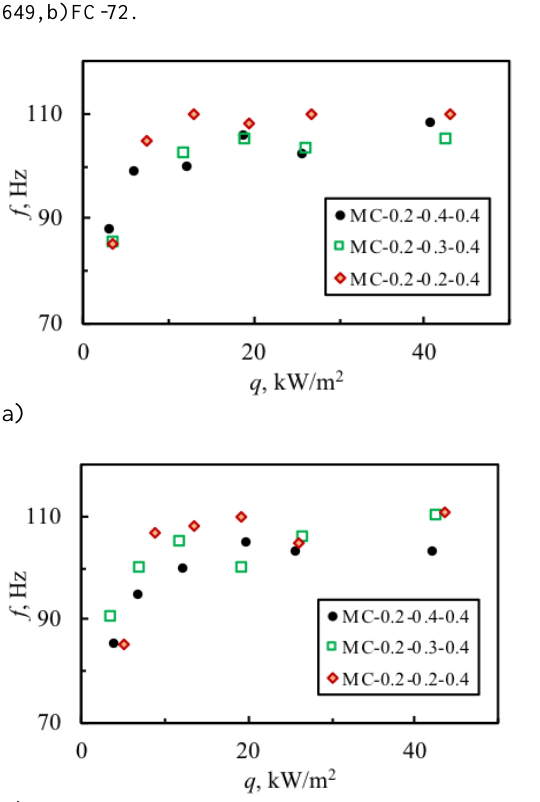
Fig. 8. Averaged bubble departure diameters with a) Novec- 649, b) FC-72.